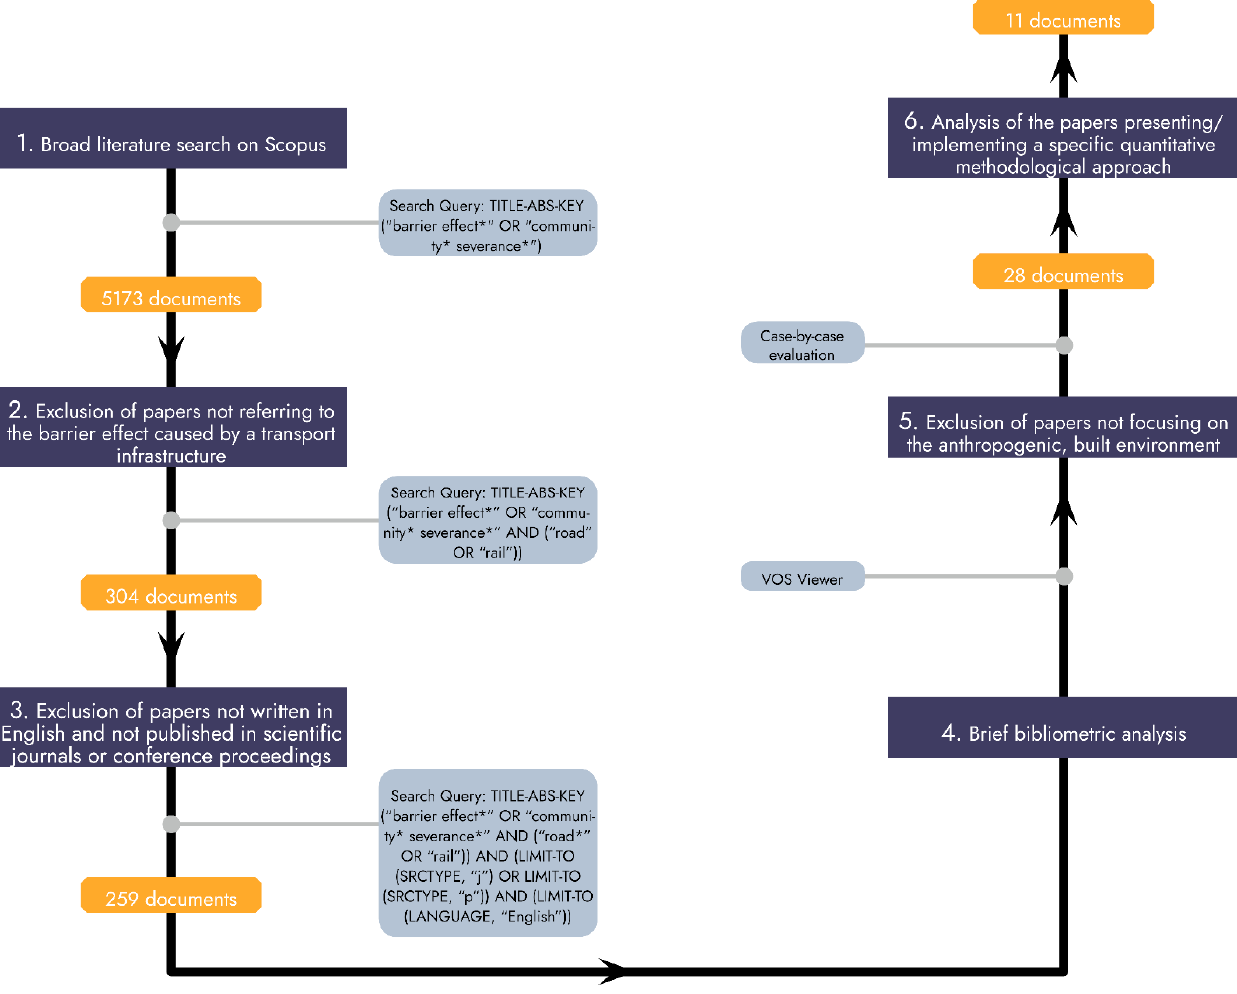
Figure 2. The steps composing the systematic literature review process.